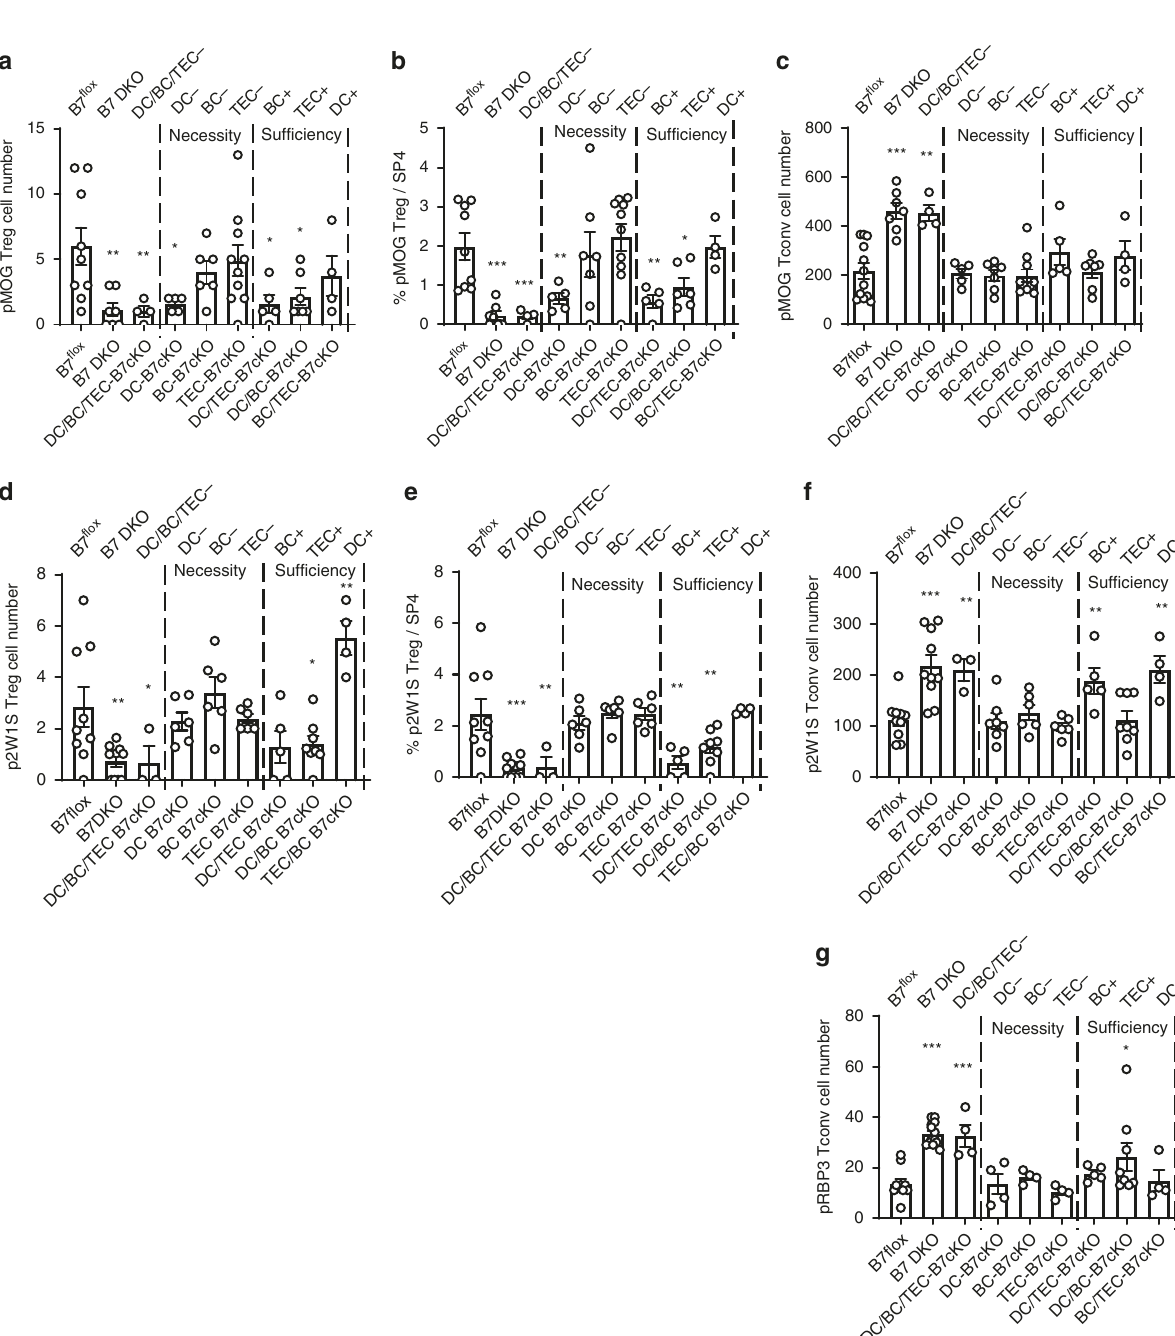
Fig. 6 Unique role of TEC, DC, and B cells for B7-CD28 dependent clonal deletion and Treg cell generation of antigen-speci fi c thymocytes. a pMOG- speci fi c SP4 Treg cell number in each B7cKO strain. p = 0.0062 (B7 DKO), 0.0323 (DC − ), 0.0456 (TEC + ), 0.0322 (BC + ), 0.0193 (DC/BC/TEC − ). b pMOG-speci fi c SP4 Treg cell frequency among total pMOG-speci fi c SP4 thymocytes. p < 0.0001 (B7 DKO), p = 0.0049 (DC − ), 0.0249 (TEC + ), 0.0027 (BC + ), 0.0003 (DC/BC/TEC − ). c pMOG-spe c i fi c SP4 Tconv cell number in each B7cKO strain. p = 0.0001 (B7 DKO), 0.0019 (DC/BC/TEC-). a , b n = 9 (7 fl ox ), c n = 12 (7 fl ox ), a – c n = 7 (B7 DKO), 4 (DC/BC/TEC − ), 5 (DC − ), 7 (BC − ), 10 (TEC − ), 5 (BC + ), 7 (TEC + ), 4 (DC + ). d p2W1S-speci fi c SP Treg cell number in each B7cKO strain. p = 0.0030 (B7 DKO), 0.0332 (TEC + ), 0.0026 (DC + ), 0.0330 (DC/BC/TEC − ). e p2W1S-speci fi c SP4 Treg cell frequency among total p2W1S-speci fi c SP4 thymocytes. p < 0.0001 (B7 DKO), p = 0.0013 (BC + ), 0.0048 (TEC + ), 0.0024 (DC/BC/TEC − ). f p2W1S-speci fi c SP4 Tconv cell number in each B7cKO strain. p < 0.0001 (B7 DKO), p = 0.0383 (BC + ), 0.0075 (TEC + ), 0.0227 (DC/BC/TEC − ). d – f n = 9 (B7 fl ox ), 10 (B7 DKO), 3 (DC/BC/TEC − ), 6 (DC − ), 6 (BC − ), 6 (TEC − ), 5 (BC + ), 8 (TEC + ), 4 (DC + ). g pRBP3-speci fi c SP4 Tconv cell number in each B7cKO strain. p < 0.0001 (B7 DKO), p = 0.0008 (DC/BC/TEC − ), 0.0163 (TEC + ). n = 10 (B7 fl ox ), 13 (B7 DKO), 4 (DC/BC/TEC − ), 4 (DC − ), 4 (BC − ), 4 (TEC − ), 5 (BC + ), 8 (TEC + ), 4 (DC + ). a – g Data are mean ± SEM with dots representing individual values of biologically independent